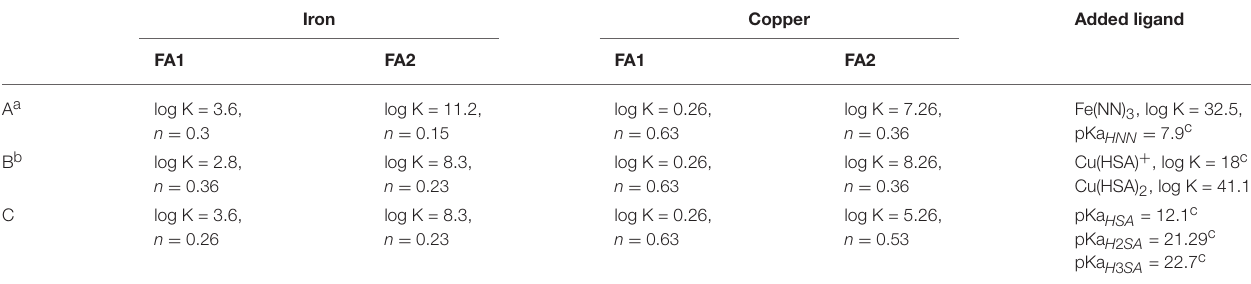
TABLE 3 | Constants used for NICA-Donnan modeling. Iron Copper Added ligand